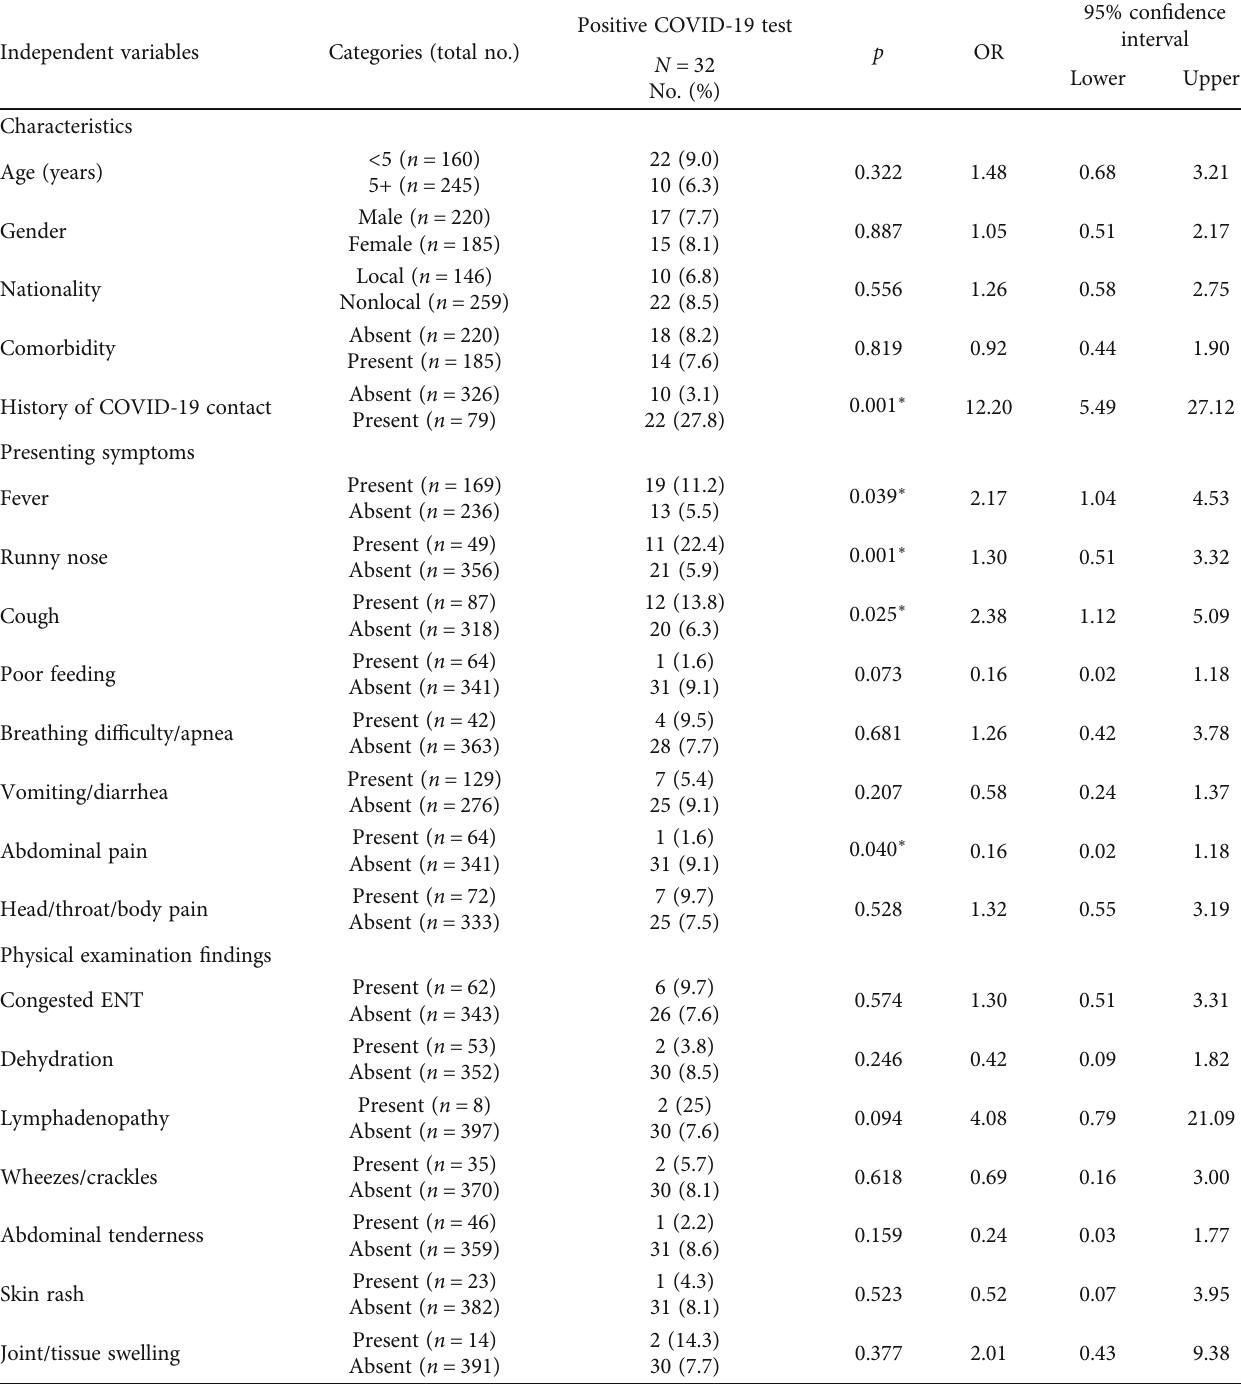
Table 1: Univariate logistic regression of the associated factors (characteristics, presenting symptoms, and physical examination fi ndings) of positive COVID-19